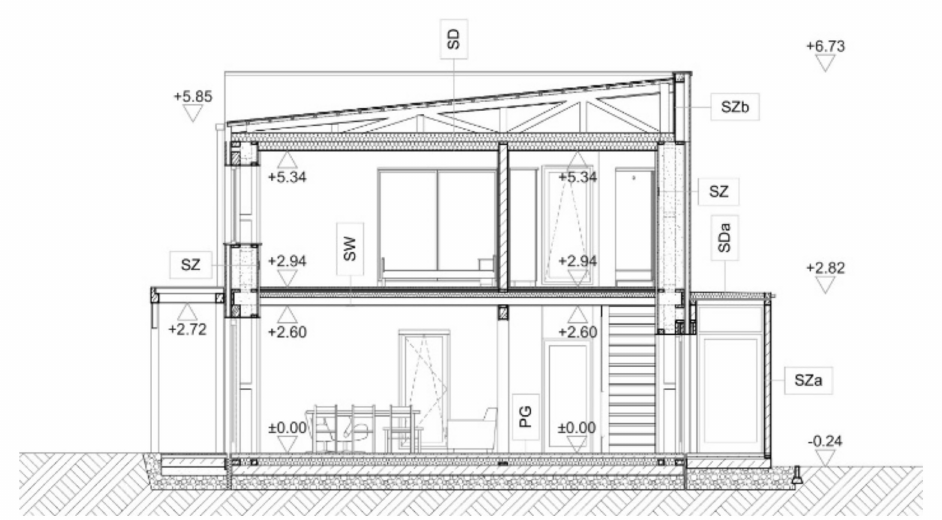
Figure 9. Model A2SB. Section A. Scale of 1:100. Source: own study using ARCHICAD